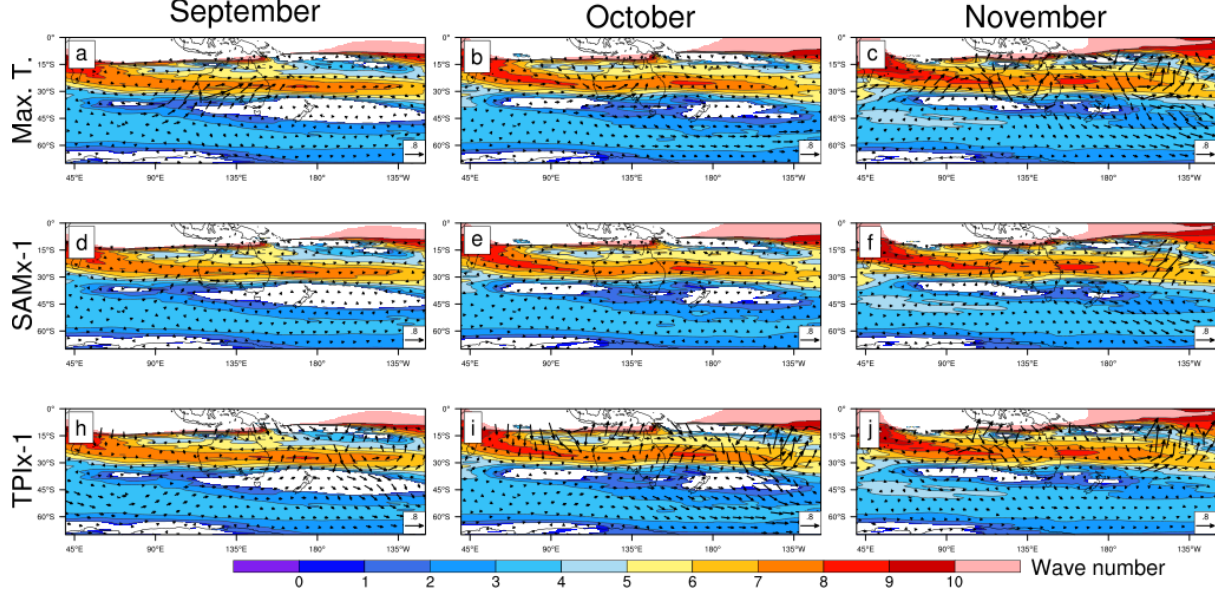
Figure 4. Total wave number ( K s ) calculated for September, October, and November. Vectors are the wave activity flux repeated from Fig.